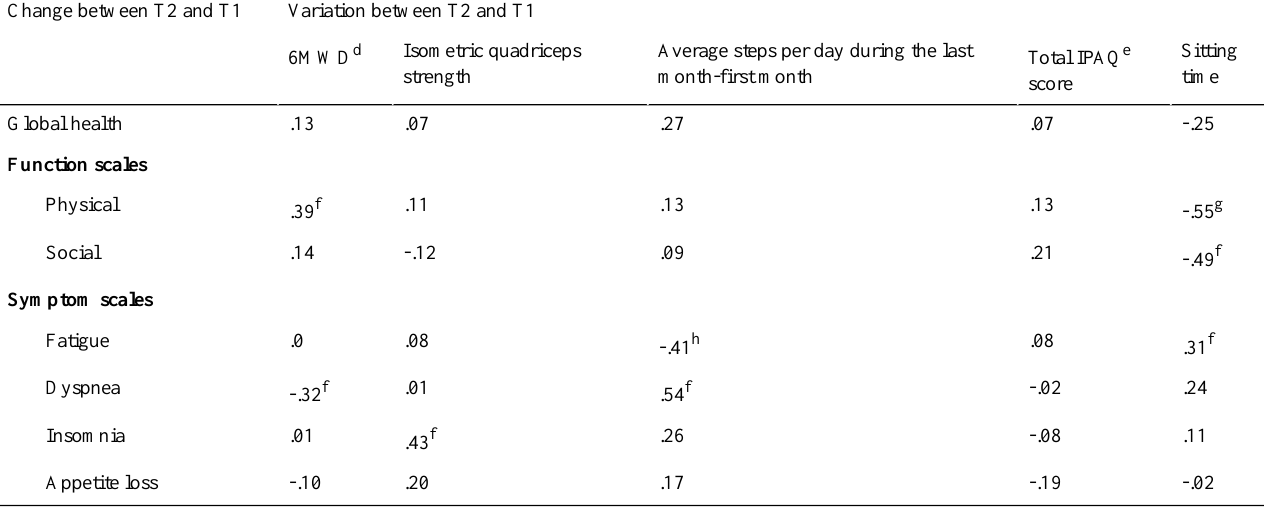
Table 4. Spearman correlations between physical activity and quality of life and differences between T2 a and T1 b in the ABLE c